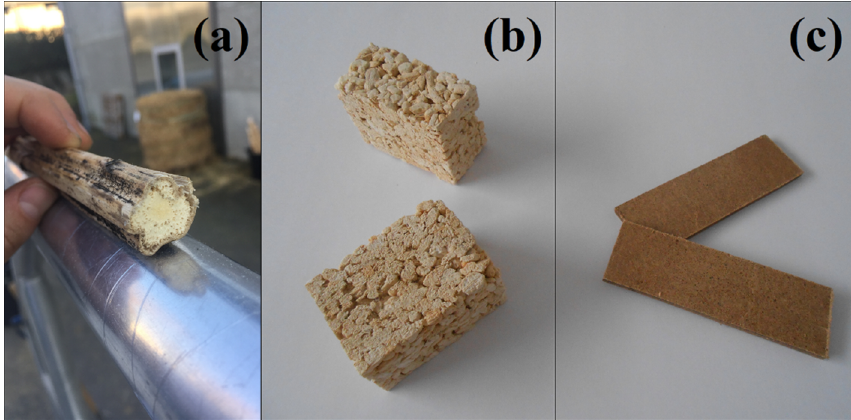
Figure 2. ( a ) Photograph of the amaranth stem (cross section); ( b ) Photograph of the optimal insulation block from the BP pith fraction; ( c ) Photograph of the optimal hardboard (HB6) from extrusion-refined bark.